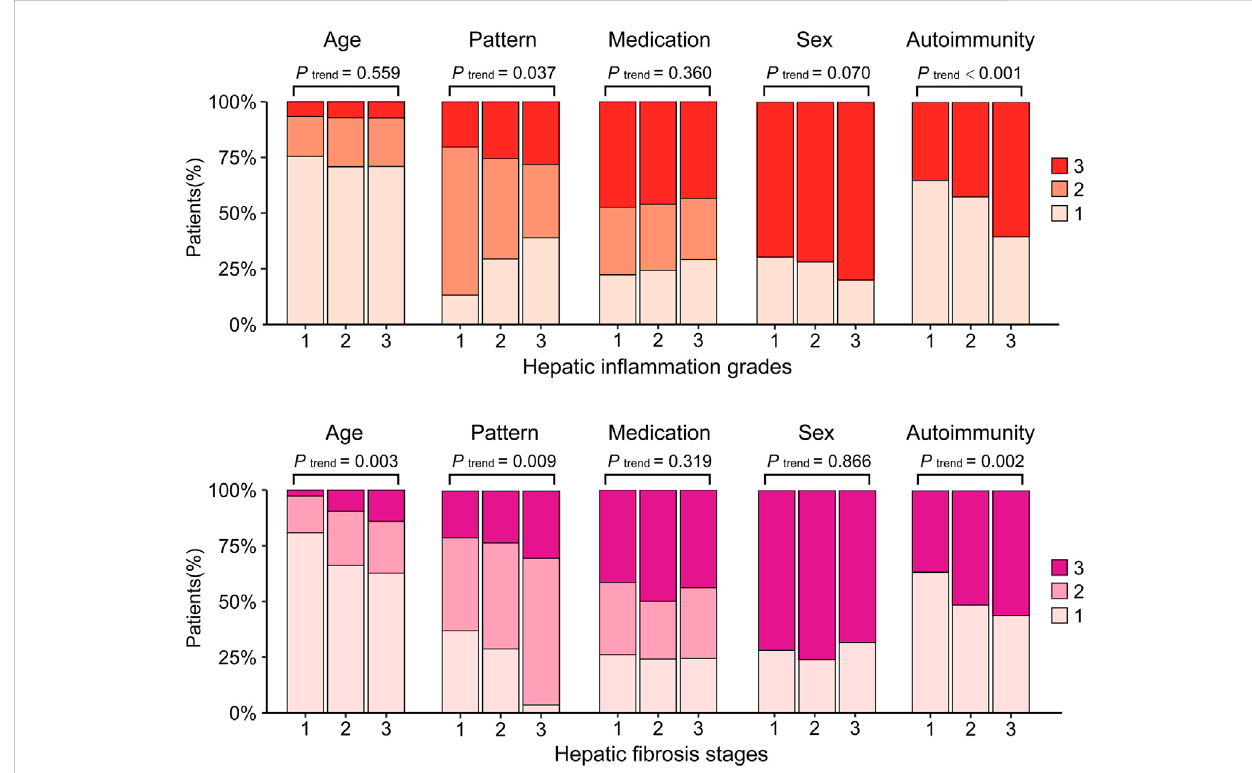
FIGURE 3 The clinical characteristics by histological evaluation.Hepatic in fl ammation grade: 1: G0-1; 2: G2; 3: G3-4. Hepatic fi brosis stage: 1: S0-1, 2: S2-3, 3: S4. Age, 1: ≤ 65 years, 2: 65 – 70 years, 3: > 70 years. Pattern, 1: hepatocellular; 2: Cholestatic; 3: Mixed. Medication, 1: Synthetic drugs; 2: Traditional Chinese Medicine or herbal and dietary supplements; 3: Combined. Sex, 1: Male; 3: Female. Autoimmunity: 1: No; 3: Yes.